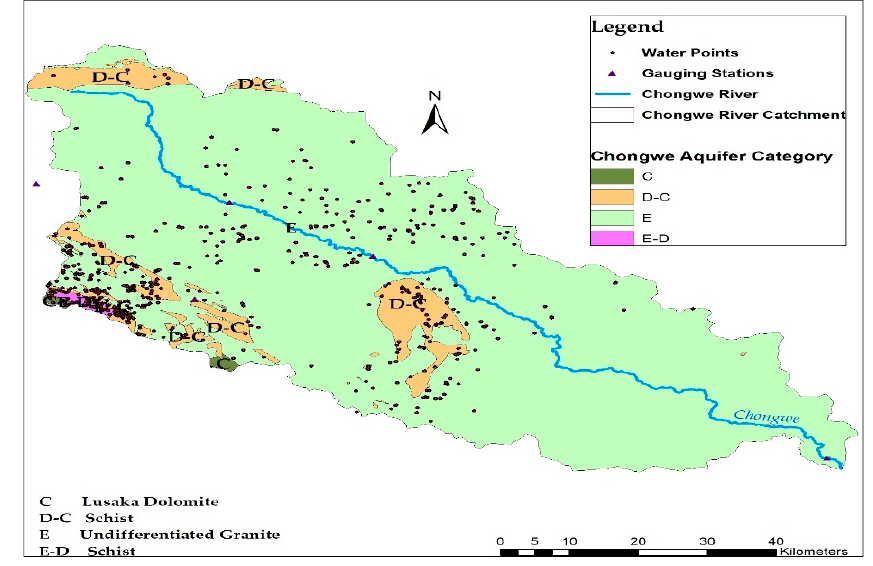
Figure 2 . Hydrogeology map of Chongwe River catchment (modified after [13]) . Figure 2. Hydrogeology map of Chongwe River catchment (modified after